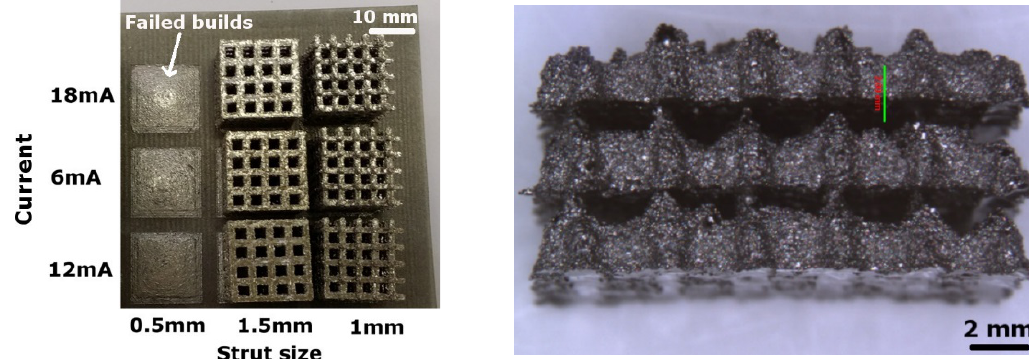
Figure 4. γ -TiAl porous structures built by EBM using the standard scan strategy ( left ); vertically disconnected layers in a failed build of the 0.5 mm strut ( right ).